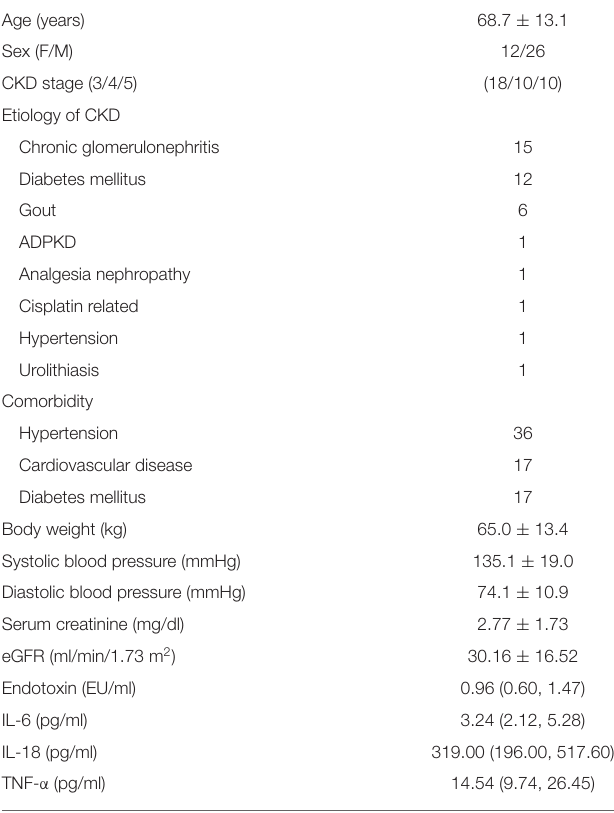
TABLE 1 | General characteristics of the